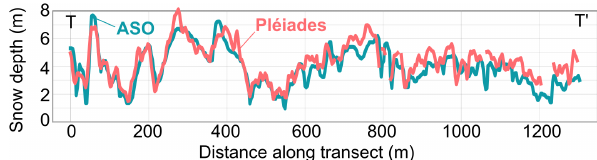
Figure 5. Transect T – T (cid:48) of snow depth visible in Fig. 4e from Pléi- ades data (pink) and ASO (blue). More transects are available in the Supplement (Figs. S3 and